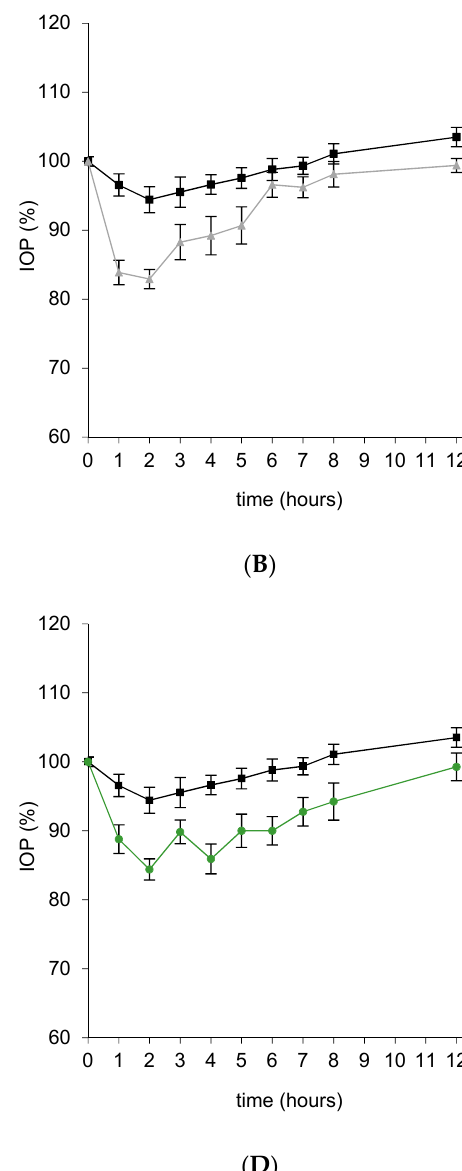
Table 3. Maximal % IOP reduction, Maximal mmHg reduction, t max , hypotensive effect duration (hours) and the area under the curve AUC (0–12h) from the developed formulations. Hypotensive Effect Maximal % IOP Maximal mmHg Formulation t max Duration (hours) Reduction Reduction Marketed formulation 21.11 ± 1.72 (TM 0.5%)